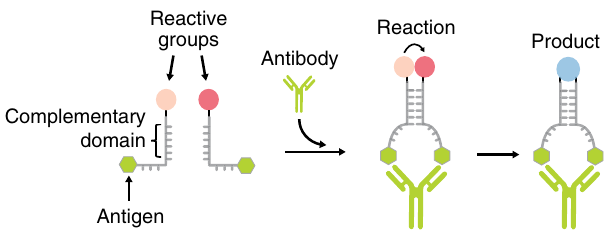
Fig. 1 Antibody-templated reactions mediated by DNA hybridization. Two complementary DNA oligonucleotides are each conjugated at one end with a reactive group and at the other end with an antigen. At low oligonucleotide concentrations (nM) duplex formation is not favored and the reaction rate between the two reactive groups is negligible. Bivalent binding of the speci fi c antibody to the two antigen-conjugated oligonucleotides induces an increase of their effective concentration thus leading to the ef fi cient duplex formation. The proximity effect induced by antibody-mediated duplex formation considerably enhances the rate of the reaction between the reactive